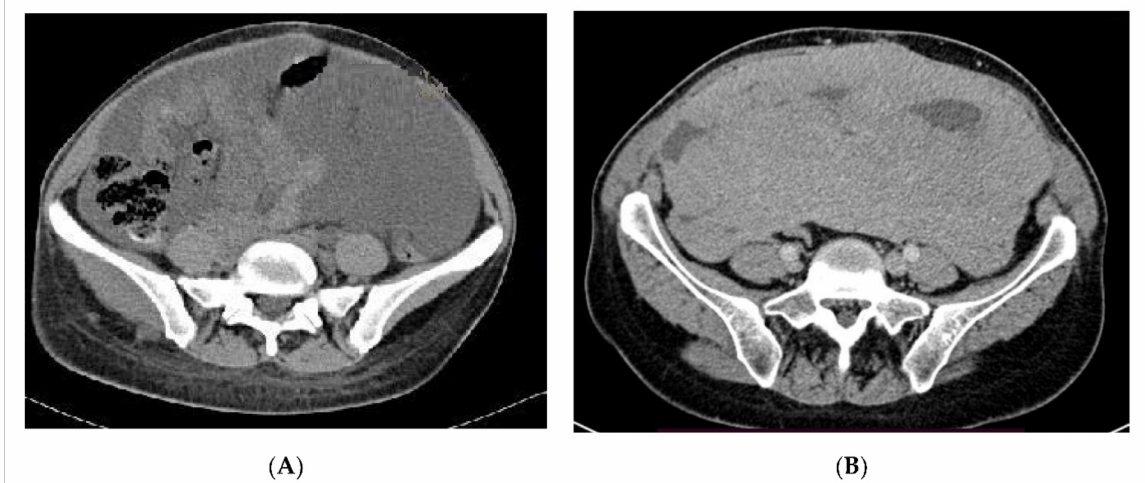
Figure 3. Patient with peritoneal effusion due to retroperitoneal LAM ( A ) and fluid resorption on sirolimus treatment ( B